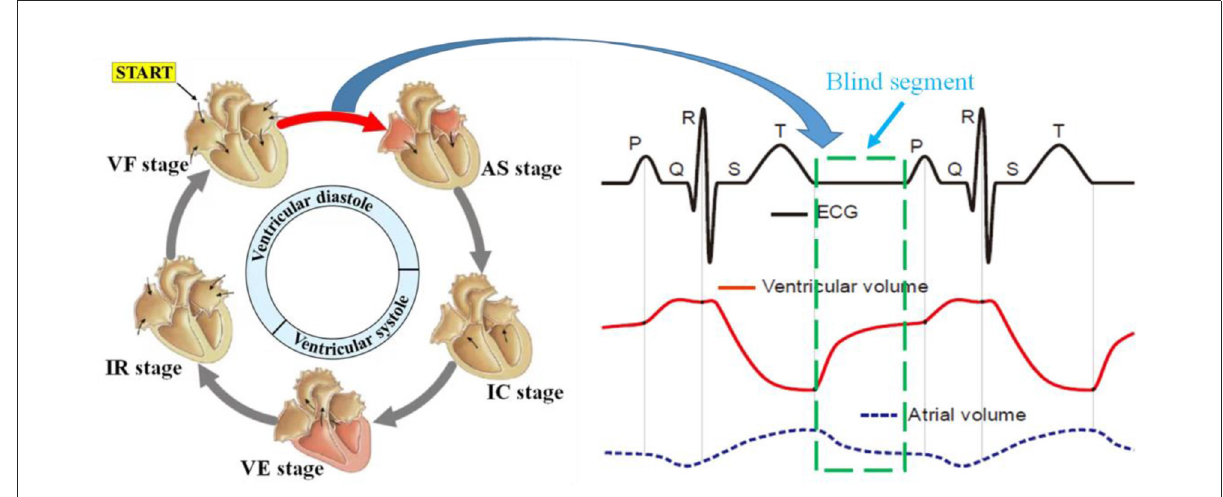
FIGURE3 Rule of electrical activity and atrioventricular volume during a cardiac